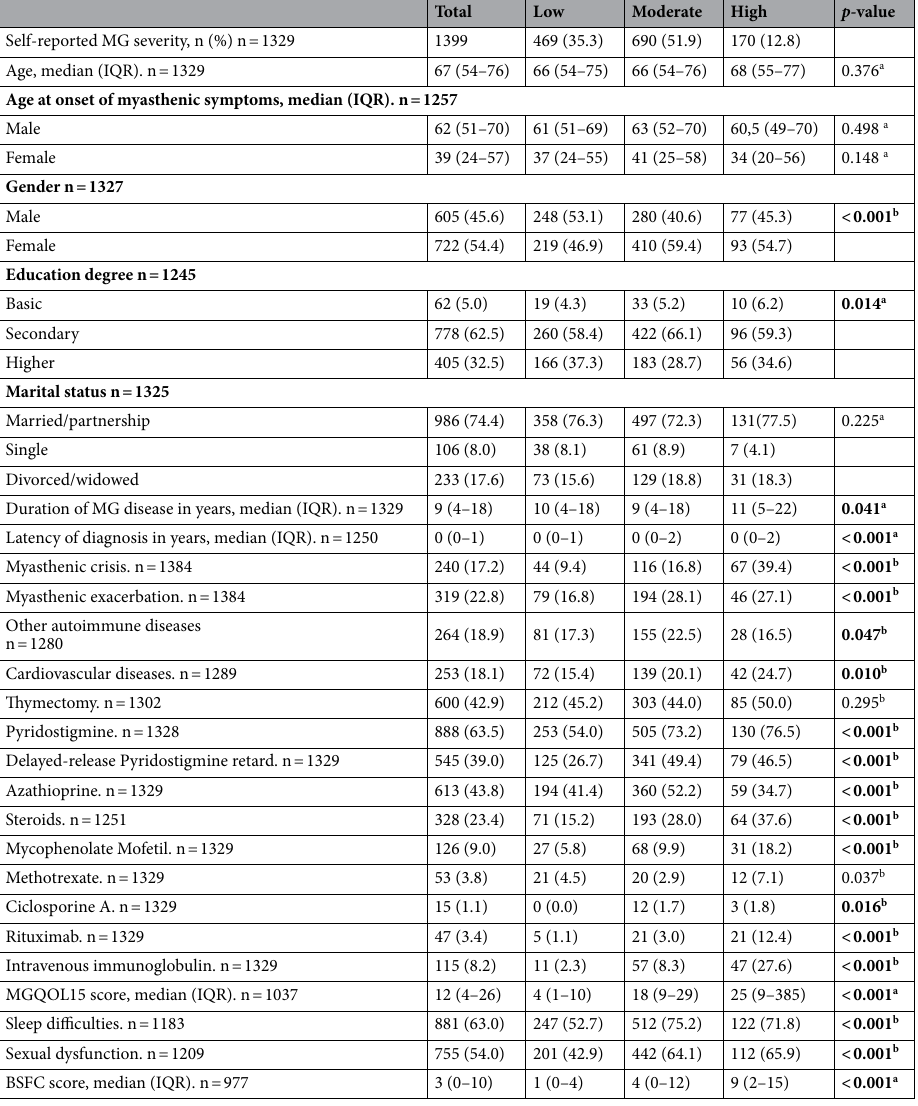
Table 1. Characteristics of MG patients. N = 1399. ICU Intensive care unit P-values refer to overall group comparisons of patients with low, moderate and high MG severity. P -values < 0.05 are marked in bold numbers. a Kruskal-Wallis-Test, b Chi-square